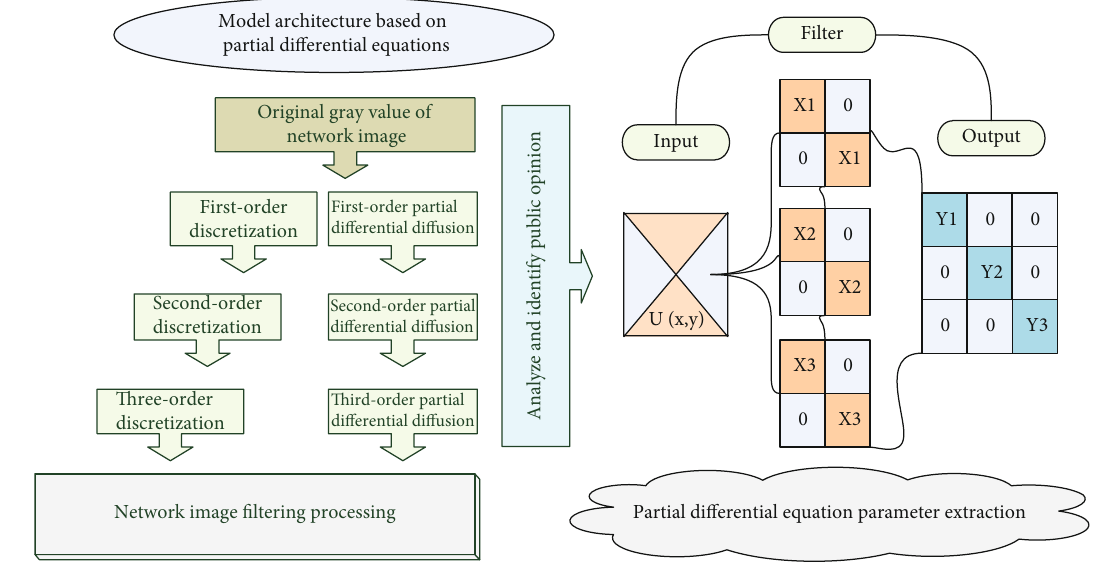
Figure 4: Network image fi ltering processing fl ow based on partial di ff erential equations. Table 2: Analysis of network image denoising data.